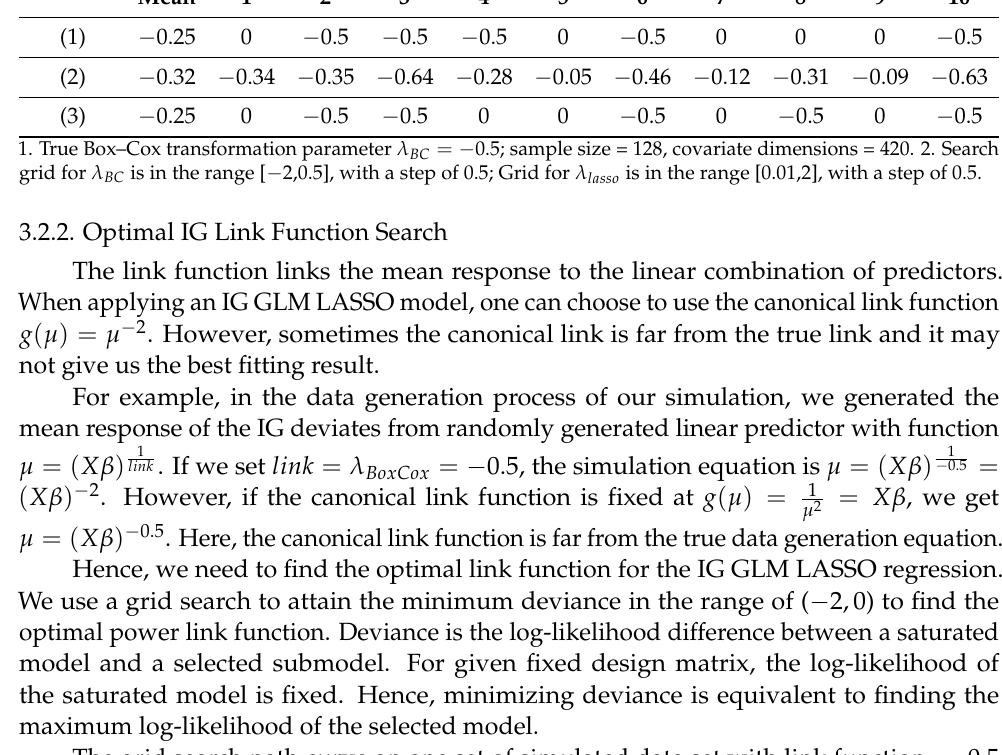
Table 3. Optimal λ BC grid search on simulated data (128 × 420; − 2:0.5:0.5). Method